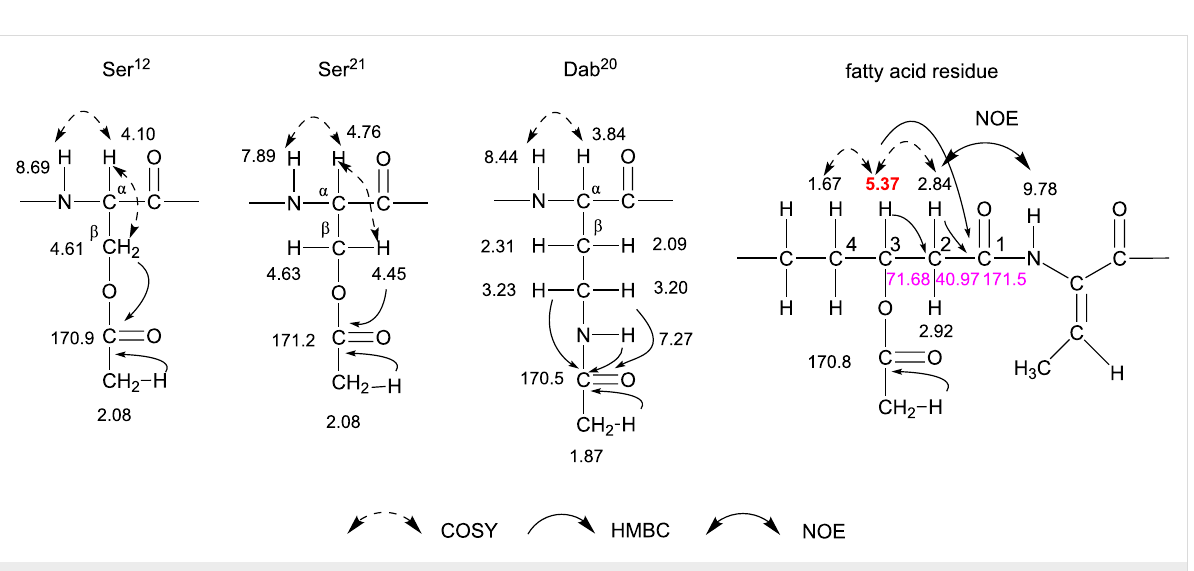
Figure 7: Determination of the positions of the acetyl groups in the tetraacetate.